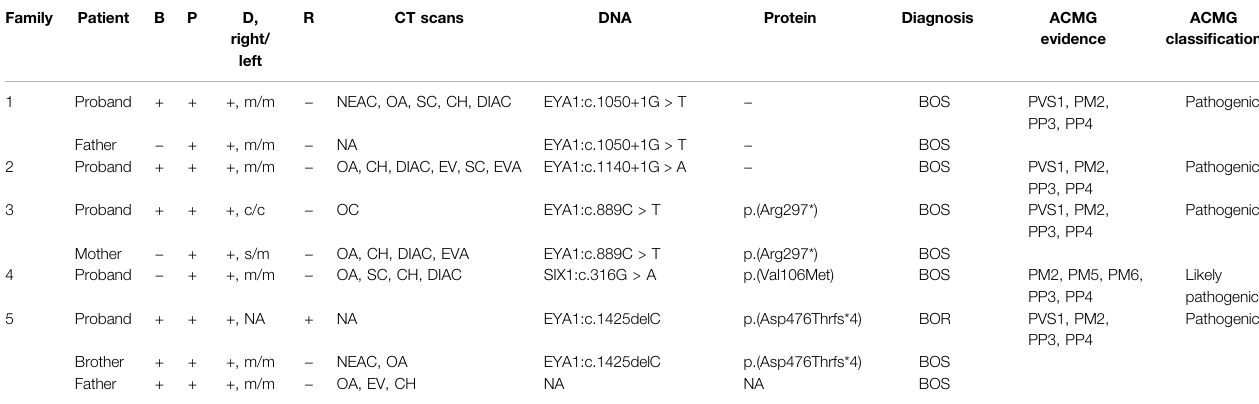
TABLE 1 | Detailed clinical features and genetic analysis of fi ve families.